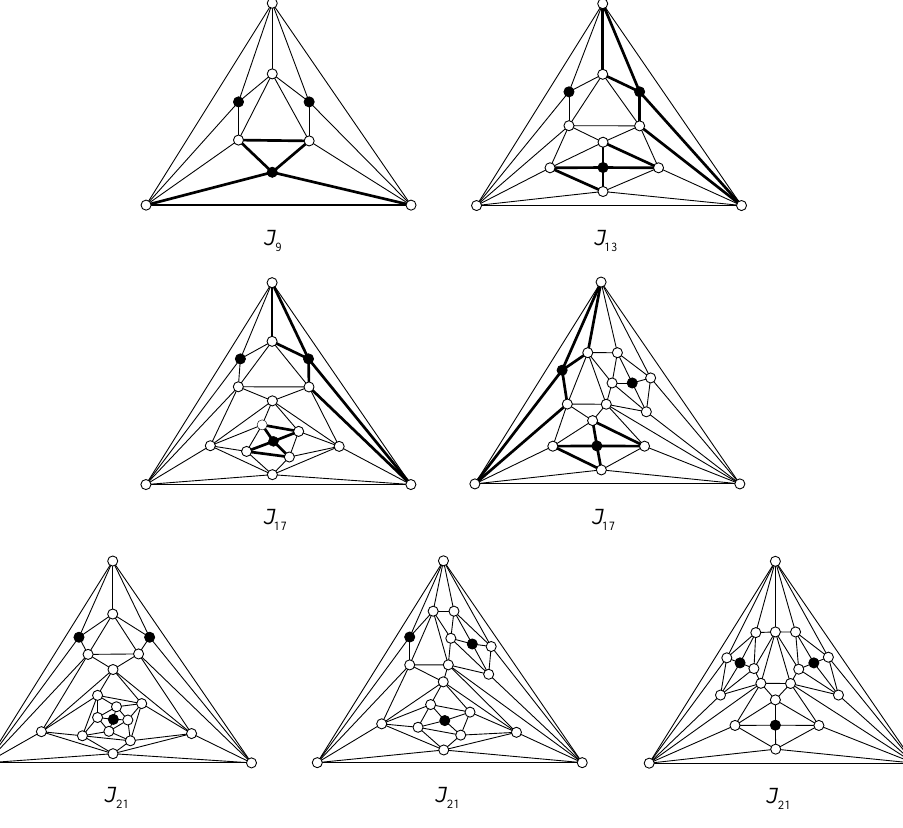
Figure 5. The dumbbell maximal planar graphs with orders 9, 13, 17 and